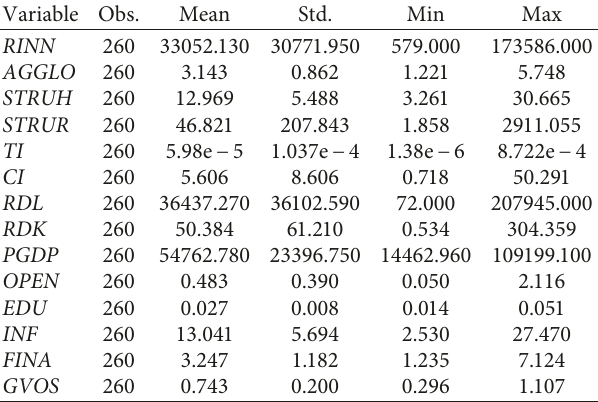
Table 1: Descriptive statistics for the variables.